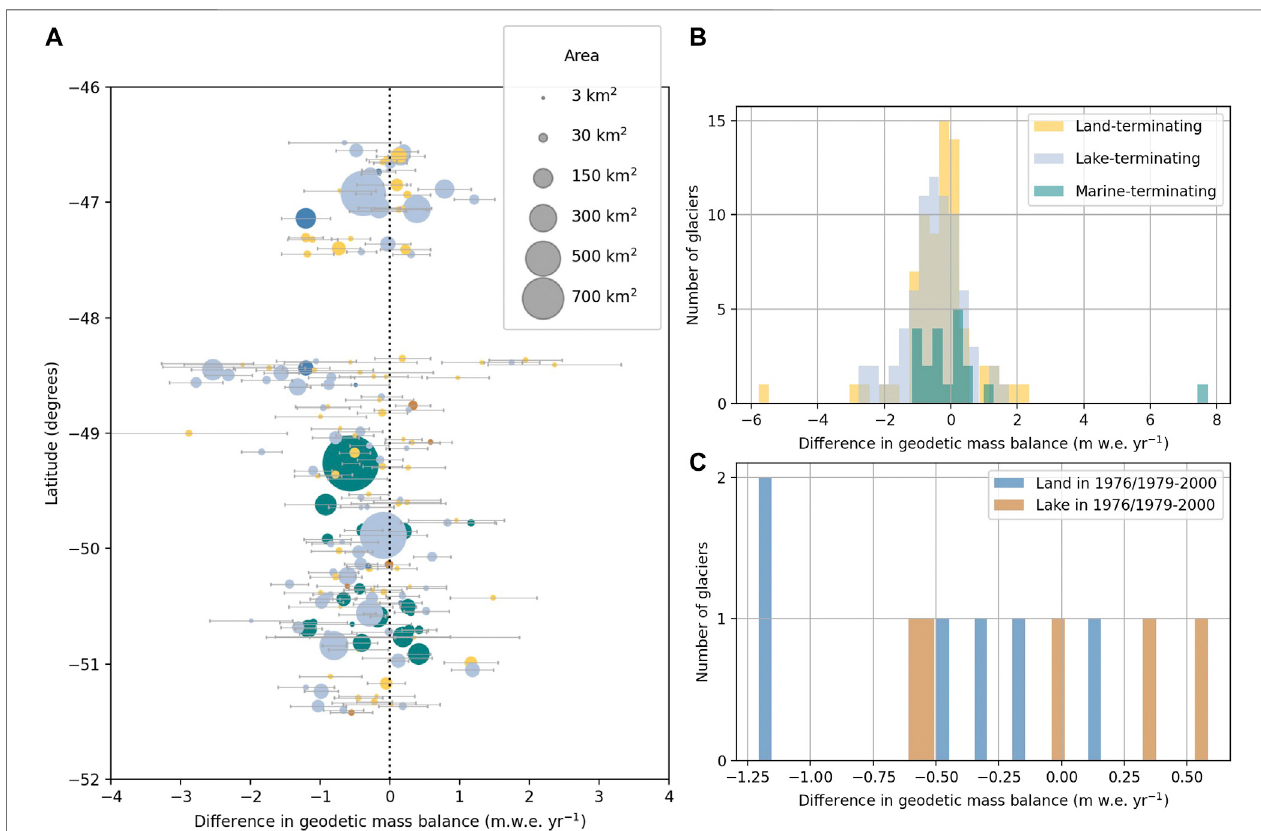
FIGURE6|(A) Historicalgeodeticmassbalancesubtractedfromthemoderngeodeticmassbalanceplottedwithlatitude,whichisclippedtoshowthedistribution around zero. Dotted line indicates where no change in geodetic mass balance occurs. (B,C) display the full range of geodetic mass balance change for different glacier terminus